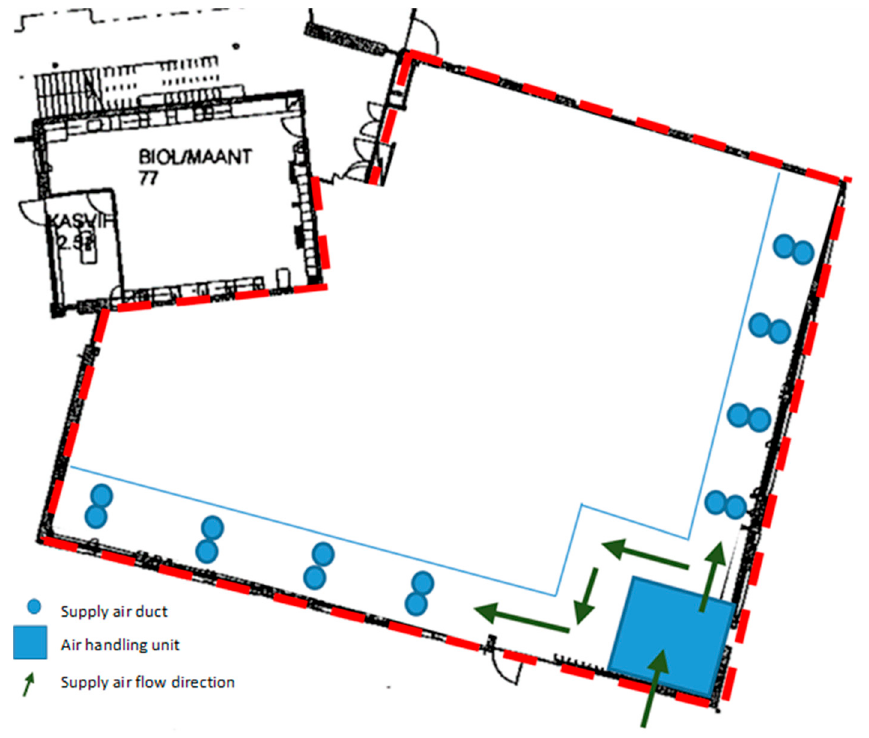
Figure 2. Location of the underground supply air chamber in relation to the studied building section (limited by a blue line): air handling unit, corridors, and terminal units of supply air ducts leading to the first- and second-floor classrooms. Direction of the supply air movement is marked with arrows.